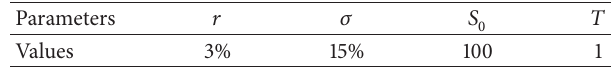
Table 1: Parameters of GBM. Parameters